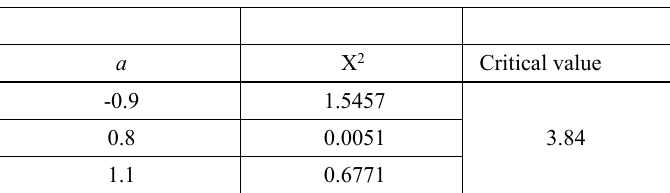
Table 1. Results of monobit